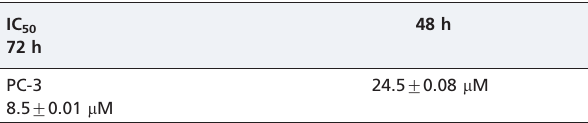
Table 2 - Doses of chrysin that inhibited cell growth by 50% (IC 50 ) in the prostate cancer cell line